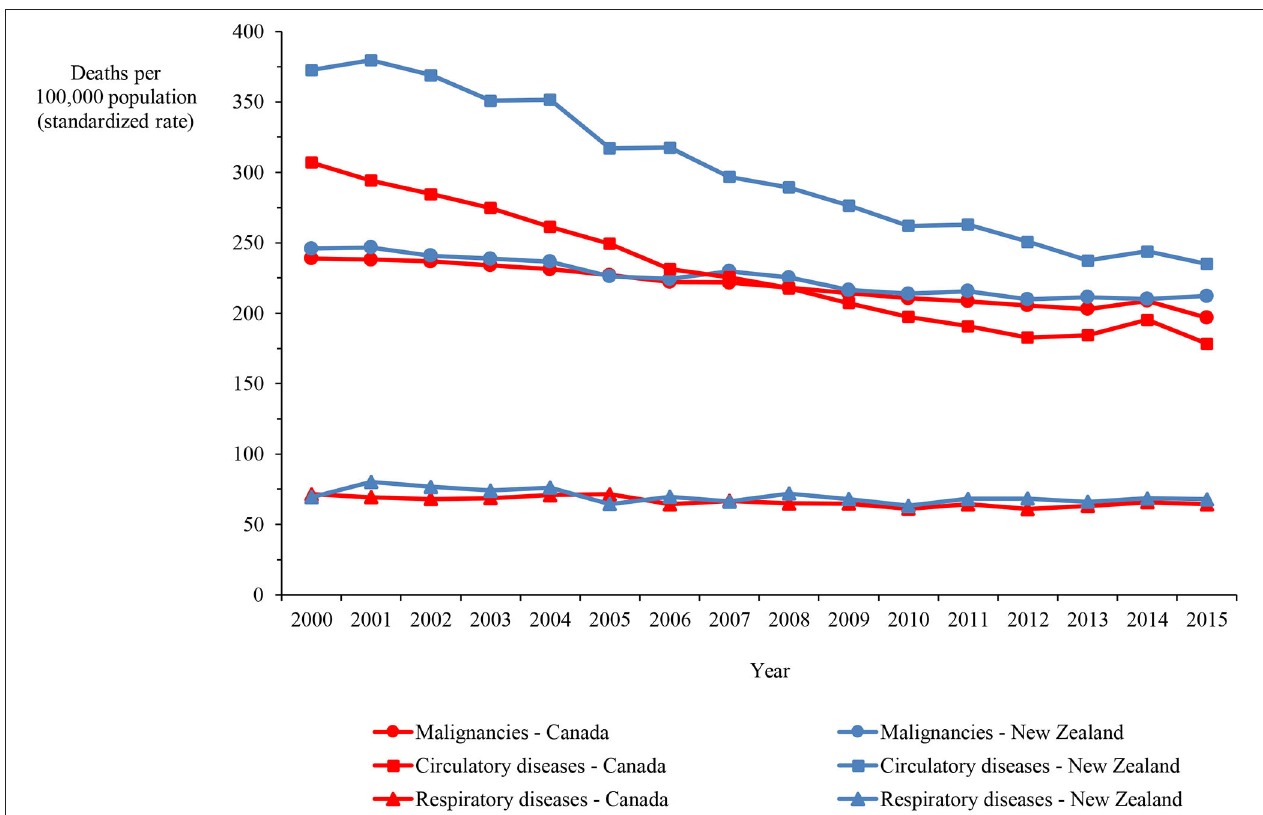
FIGURE 3 | Mortality in Canada and New Zealand from malignancies and circulatory and respiratory diseases,